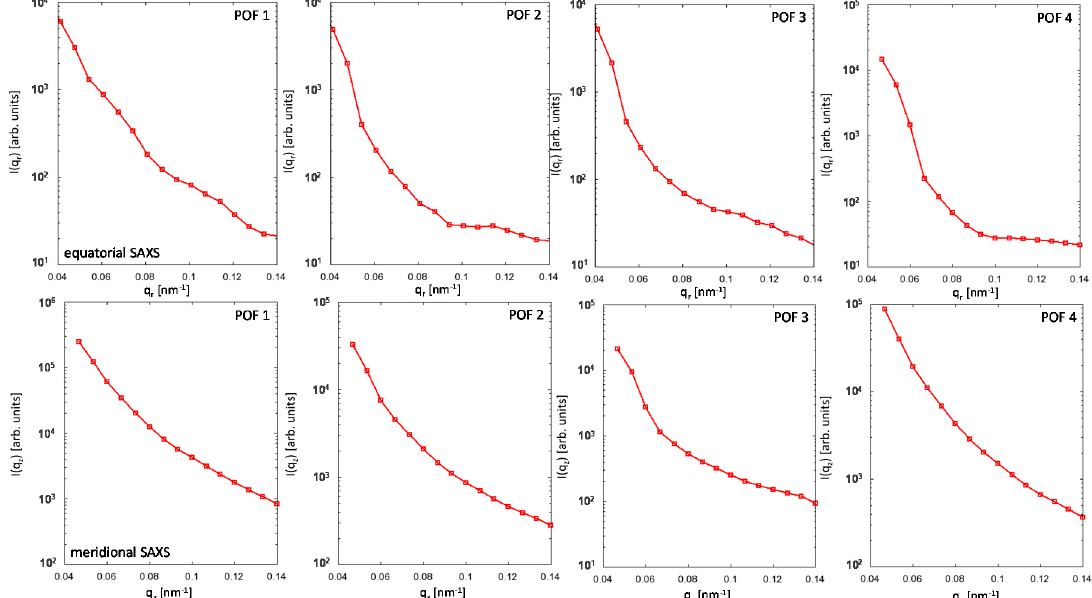
Figure 5. Extracted 1D SAXS intensity curves of the four POF samples. ( Top row ): equatorial intensities corresponding to the scattering from the fiber cross-section. ( Bottom row ) : meridional intensities corresponding to the scattering contribution along the fiber axis.